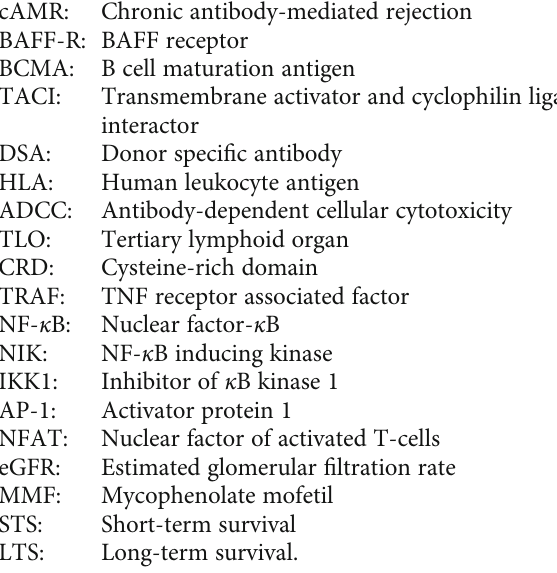
Supplementary fi gure 1: BAFF concentration in stable